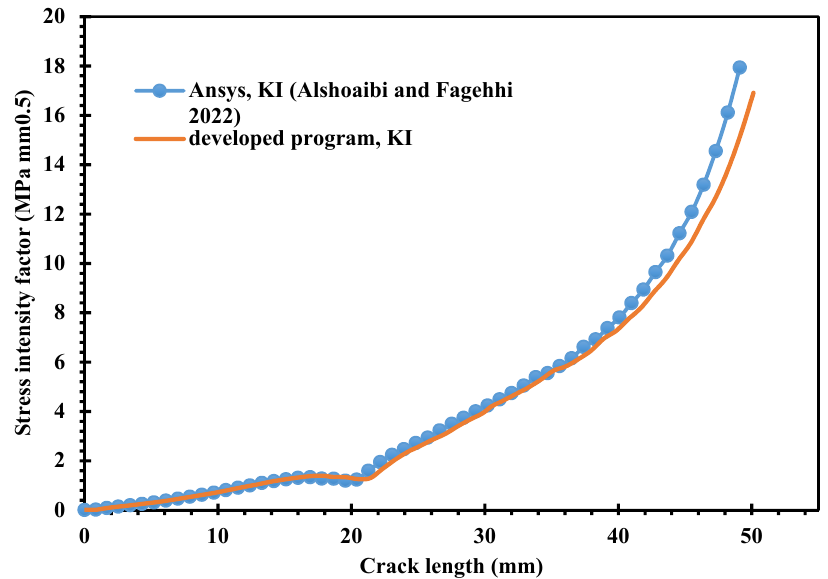
Figure 12. Predicted values of the K I in comparison to Ansys results obtained by [6].